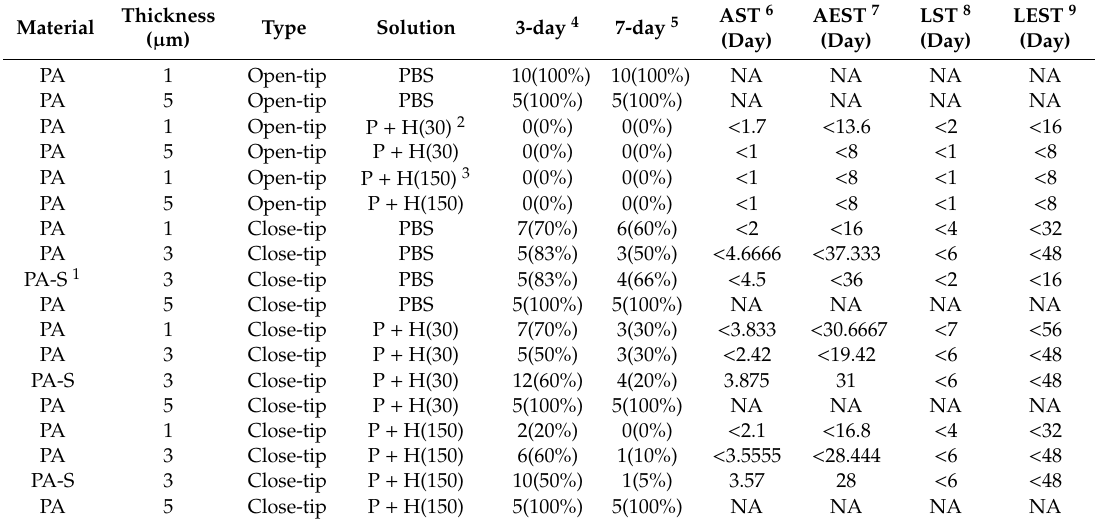
Table 2. Survival probabilities of all PA coating